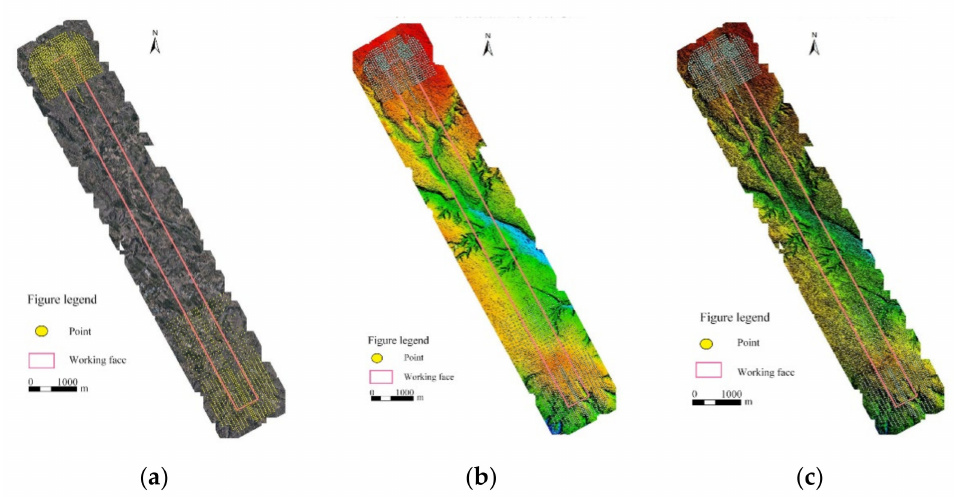
Figure 13. 3D model results: ( a ) DOM; ( b ) DEM; ( c )